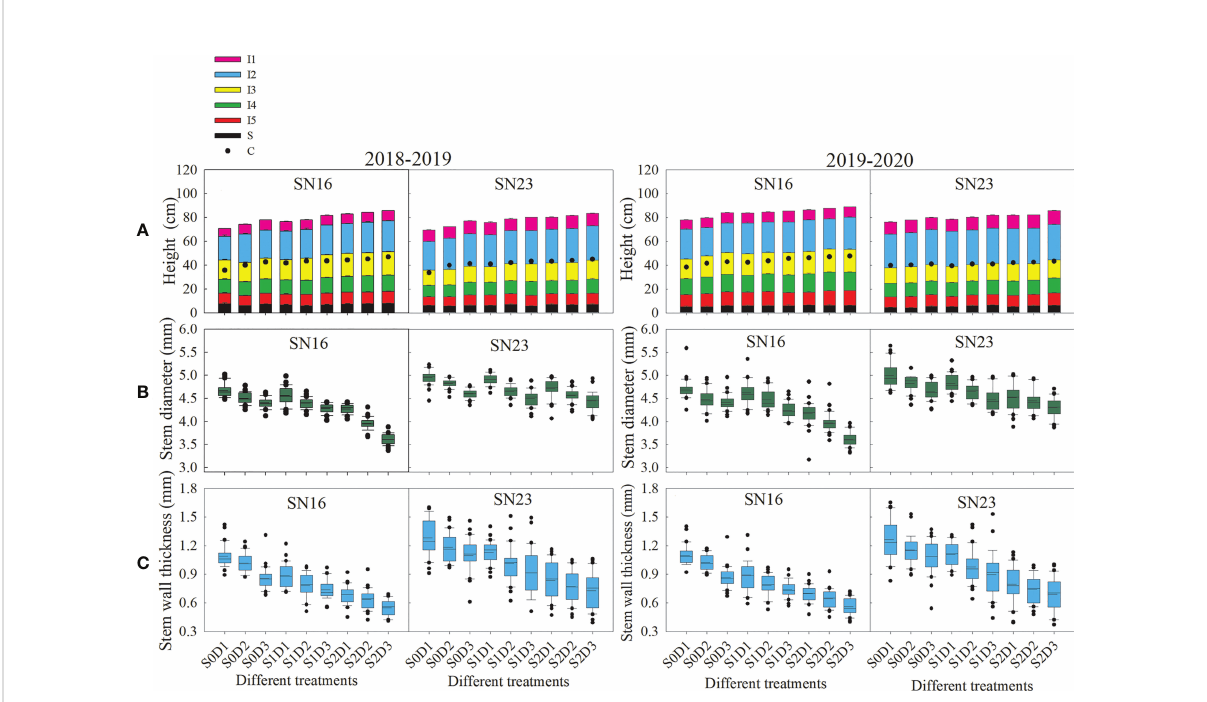
FIGURE 1 Effects of shading on morphological indexes stem of wheat under different planting densities. (A) Plant height, con fi guration of internnodes, and center of gravity of wheat at milk stage. Error bars represent the standard deviation of the mean (n = 10). (B, C) Stem diameter and wall thickness of the second basal internode. Solid lines and dotted line indicate medians and means, respectively. Box boundaries indicate upper and lower quartiles, whisker caps and points indicate internal limiting and outliers (n =